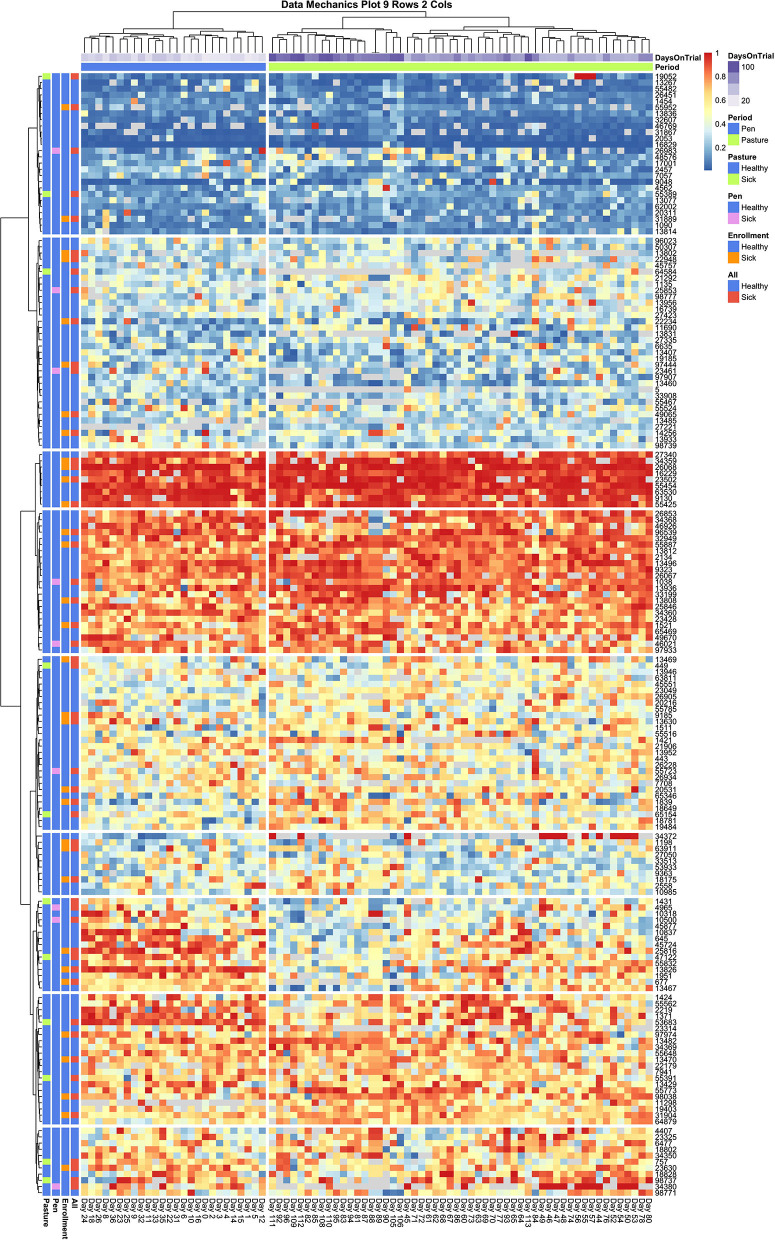
Data Mechanics visualization of all cows. Color annotations of the column axis reveal that coarser clustering along the temporal axis has revealed a perfect division of observations between pen and pasture subperiods. Scanning from left to right within the heat map, cows occupying the front and rear of the queue appear consistent in entry quantile values. Cows in the center of the herd appear to be the source of this temporal heterogeneity, as evidence by systematic changes in color along the column axis. In the cluster of animals starting with cow 1431, there is a progressive shift from the rear of the herd in the pen period toward the front of the herd in the pasture. As row color annotations reveal not all these animals have recorded health events on record, this pattern likely cannot be explained away by anomalous behaviors from acute or chronic illness.